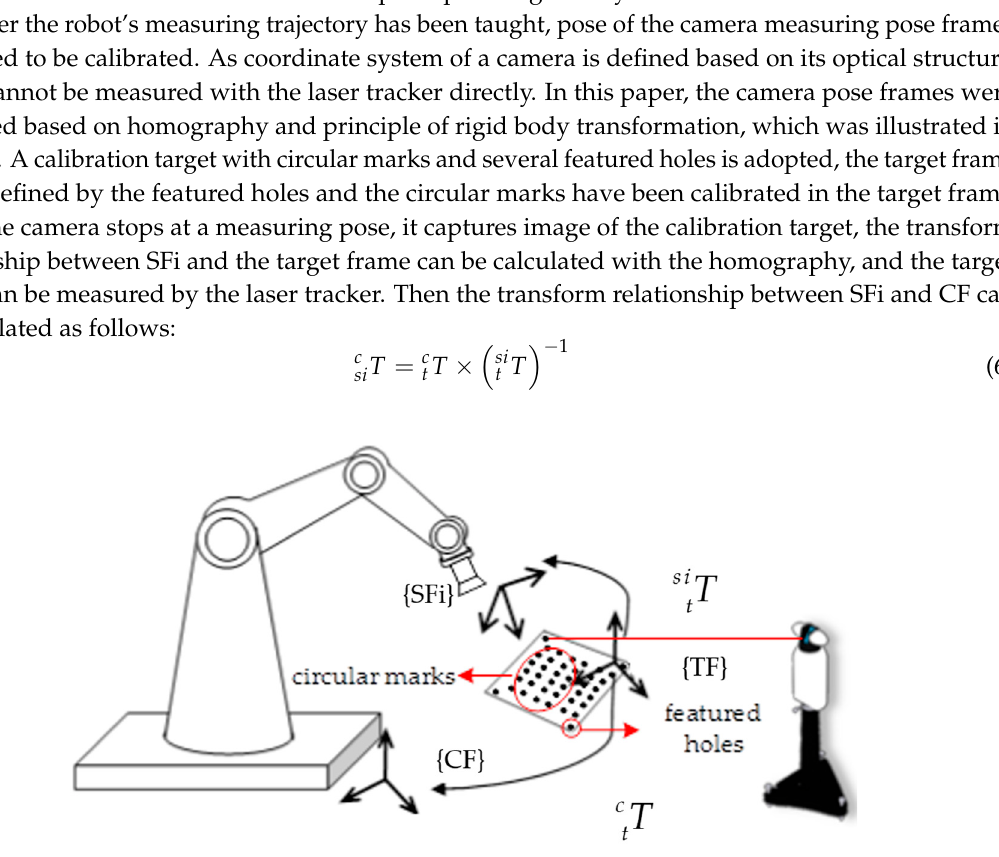
Figure 2. Calibration of the camera i-th pose frame.